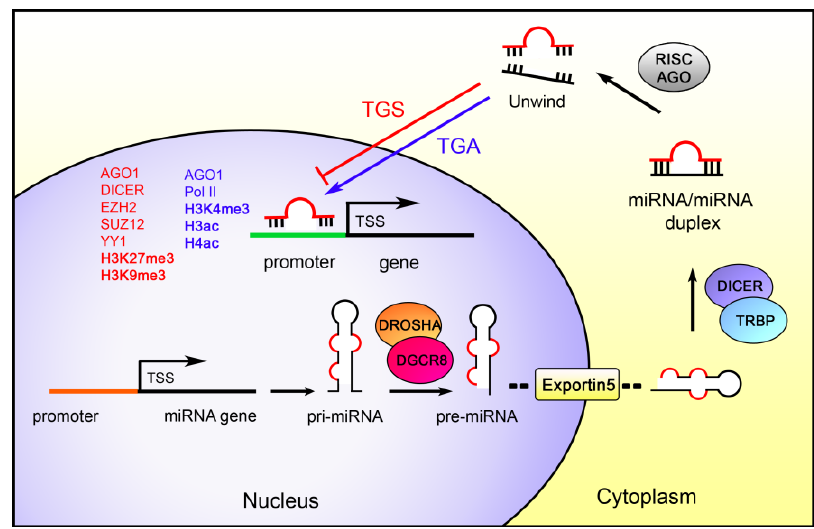
Figure 2. MicroRNAs regulate gene transcription . Nuclear miRNAs can mediate both transcriptional gene silencing (TGS) and transcriptional gene activation (TGA) by targeting gene promoters. During the TGS, AGO1, DICER, EZH2, SUZ12, and YY1 proteins can be recruited on target promoters to induce the silencing through enrichment of H3K9me3 and H3K27me3. Instead, during the TGA, target promoters exhibit the enrichment of the RNA polymerase II, H3K4me3, and H3ac, H4ac; moreover, AGO1 was also found to be associated to target promoters during TGA. In the figure, black arrows indicate the miRNAs biogenesis pathway, and red and blue lines represent miRNAs translocated back to the nucleus to mediate TGS or TGA, respectively. Chromatin modifications are represented in bold.